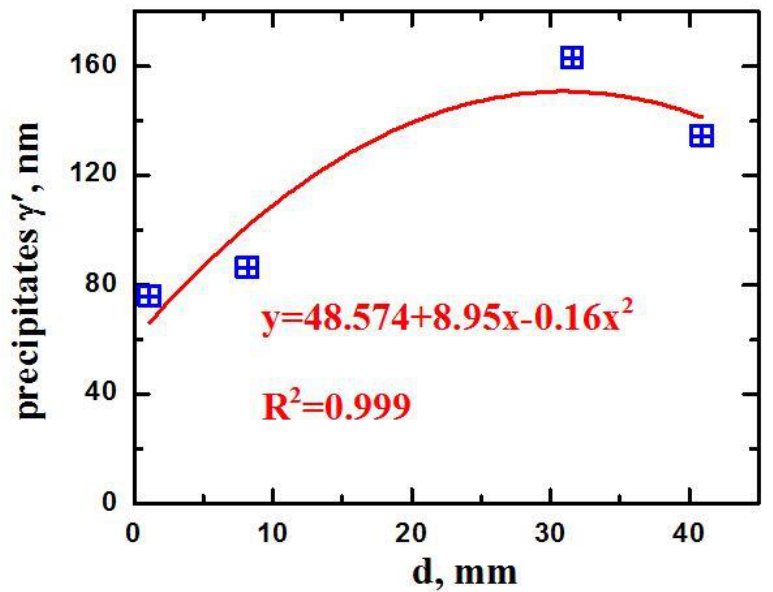
Figure 12. Dependence of the γ’ -phase emission size on the distance from the substrate.